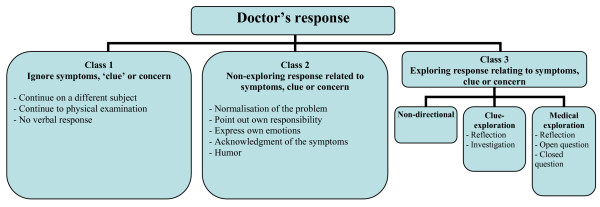
Doctor's response.